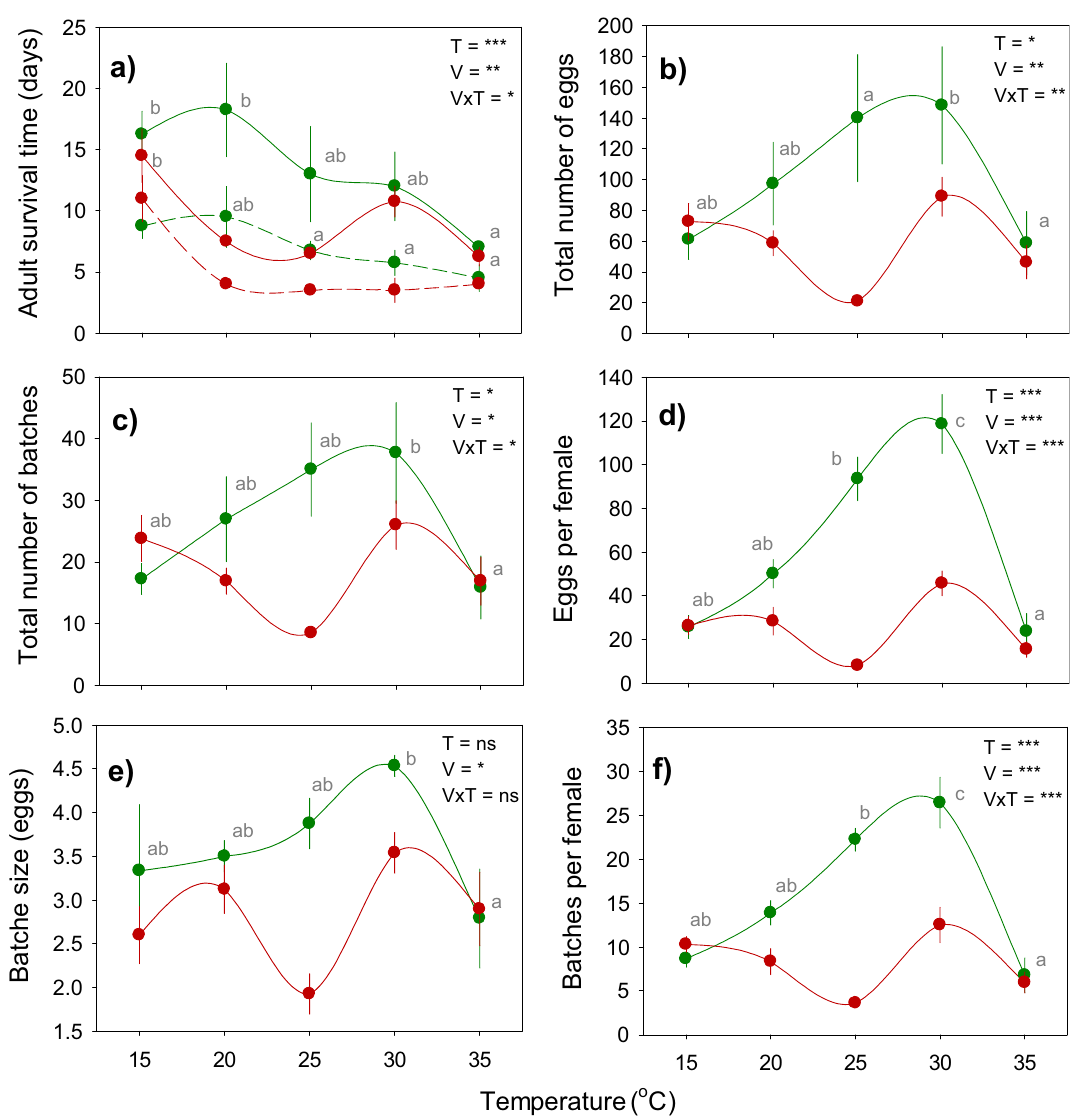
Figure 2. Mean survival and egg-laying by Nilaparvata lugens on susceptible (IR22: green circles) and resistant (IR62: red circles) rice varieties across a range of temperatures. The times to 50% (dashed lines) and 100% (solid lines) mortality of adult females are indicated in a . The total numbers of eggs ( b ), total number of batches ( c ), the number of eggs per female ( d ), batch size ( e ) and the numbers of batches per female ( f ) are also indicated. Numbers are based on accumulated data over 20 days of the experiment. Relative humidity was maintained at 80%. Bars indicate standard errors (N = 4). Effects of variety (V), temperature (T) and their interaction (V × T) are indicated as ns ( P > 0.05), * ( P ≤ 0.05), ** ( P ≤ 0.01), *** ( P ≤ 0.005); lowercase letters indicate homogenous temperature groups (Tukey, P ≤ 0.05).